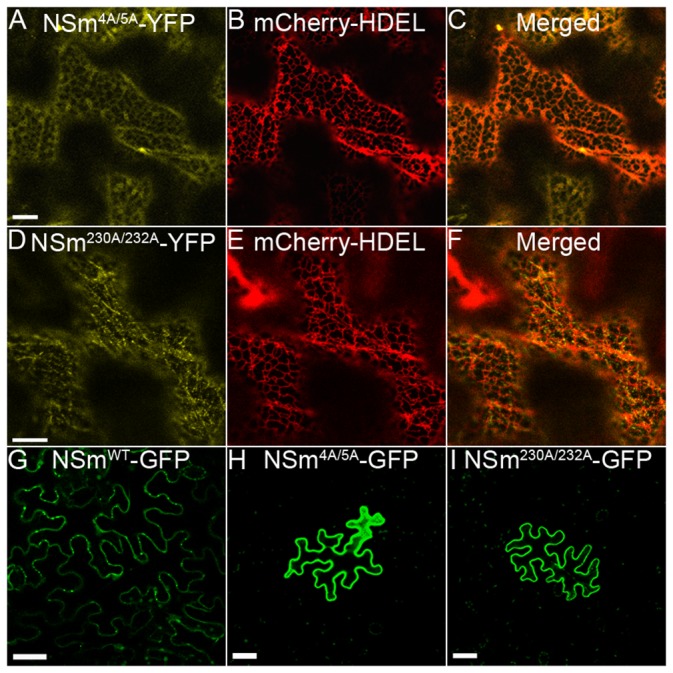
Mutations in NSm that blocked correct ER sorting or altered sorting to other subcellular localization inhibits NSm cell-to-cell movement in leaf epidermis of N. benthamiana.(A-C) Subcellular localization of NSm4A/5A mutant in epidermal cell. ER marker mCherry-HDEL was used for colocalization analysis. Bar, 10 μm. (D-F) Colocalization analysis of NSm230A/232A mutant with ER labeled by mCherry-HDEL. Bar, 10 μm. (G-I) Cell-to-cell movement analysis of NSm4A/5A (H) and NSm230A/232A (I) mutants in N. benthamiana after bombardment. NSmWT (G) was used as a positive control. Bar, 50 μm.